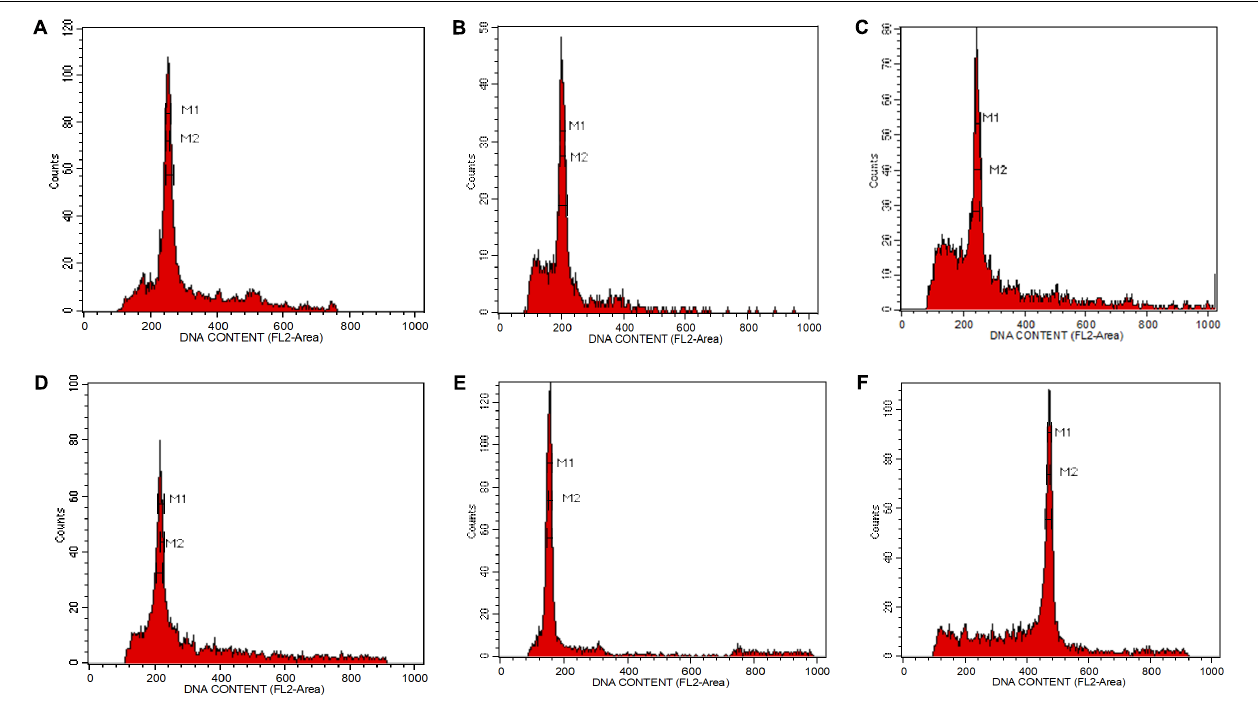
FIGURE 1 | Fluorescence intensity histogram peaks showing the number of nuclei per channel as a function of relative fluorescence obtained after flow cytometric analysis of propidium iodide-stained nuclei. (A) Aquilaria hirta , (B) Aquilaria malaccensis , (C) Aquilaria microcarpa , (D) Aquilaria sinensis , (E) Aquilaria subintegra , and (F) Elaeis guineensis , which acted as an external reference